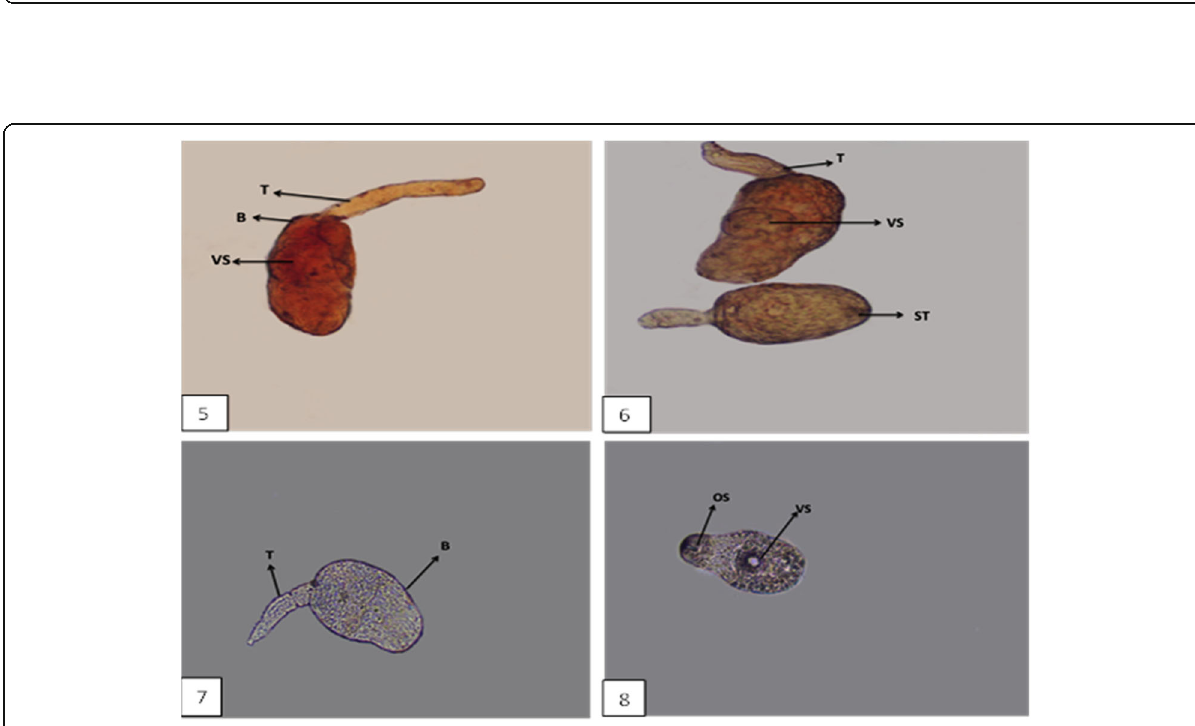
cercaria while alive; (8) palaeorchis cercaria while alive; tail (T); (B) body of cercariae; (OS): oral sucker; ventral sucker